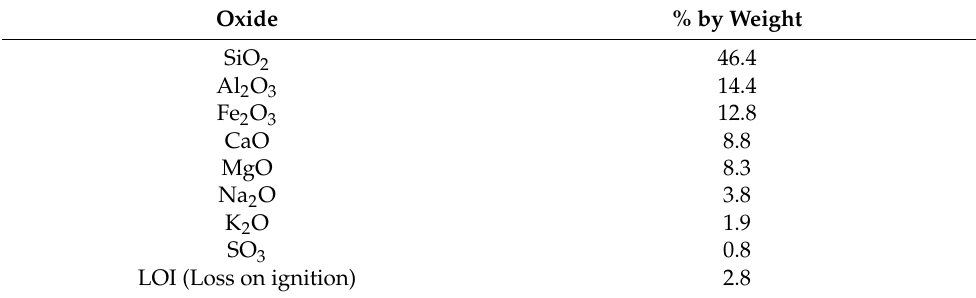
Table 2. Chemical composition of volcanic ash, VA [31].